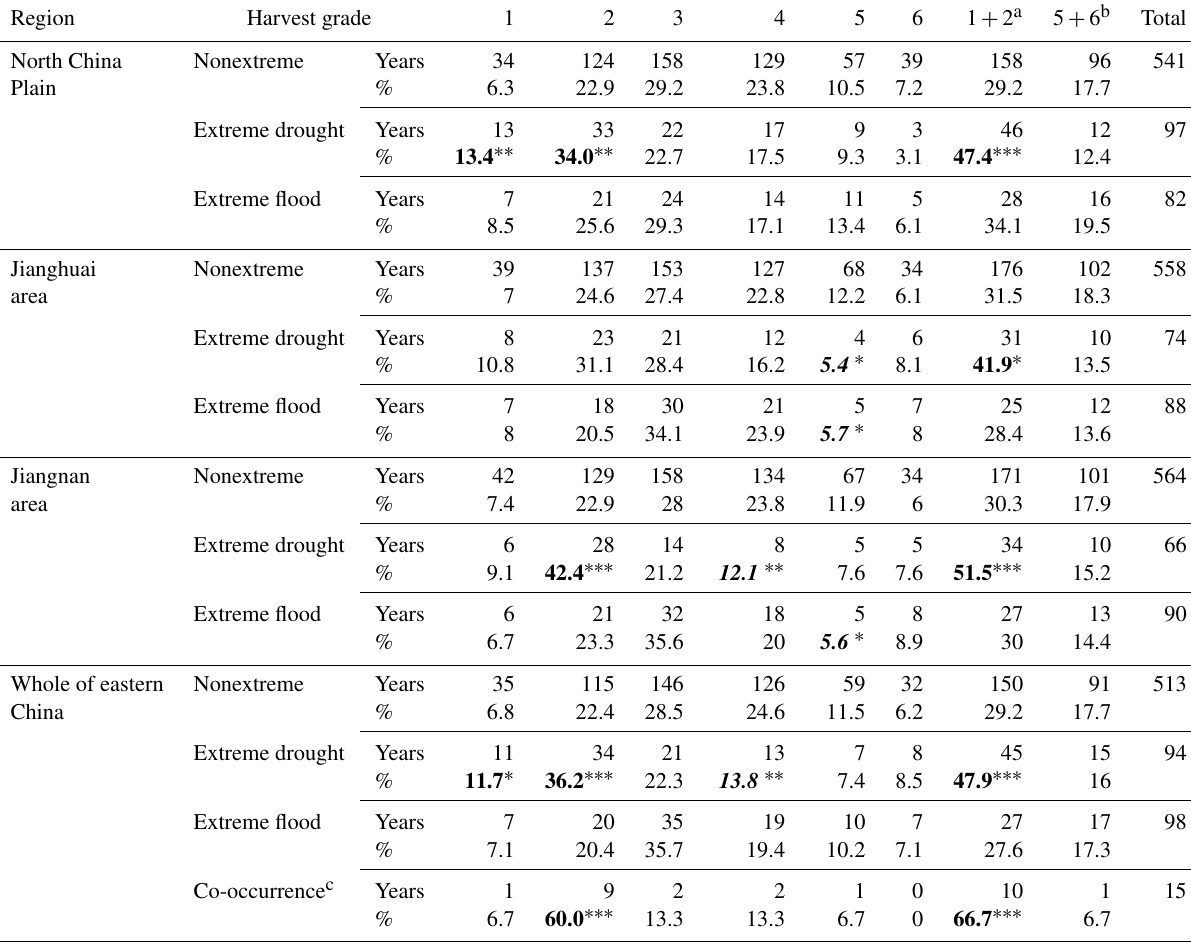
Table 4. Comparison of the frequency of each harvest grade between extreme drought/flood years and nonextreme years, 801–1910. Region Harvest grade 1 North China Nonextreme Plain